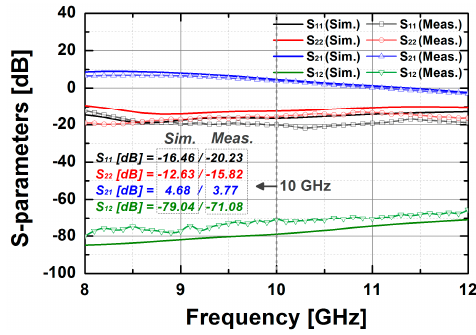
Figure 21. The measured noise figure of the implemented TRM.